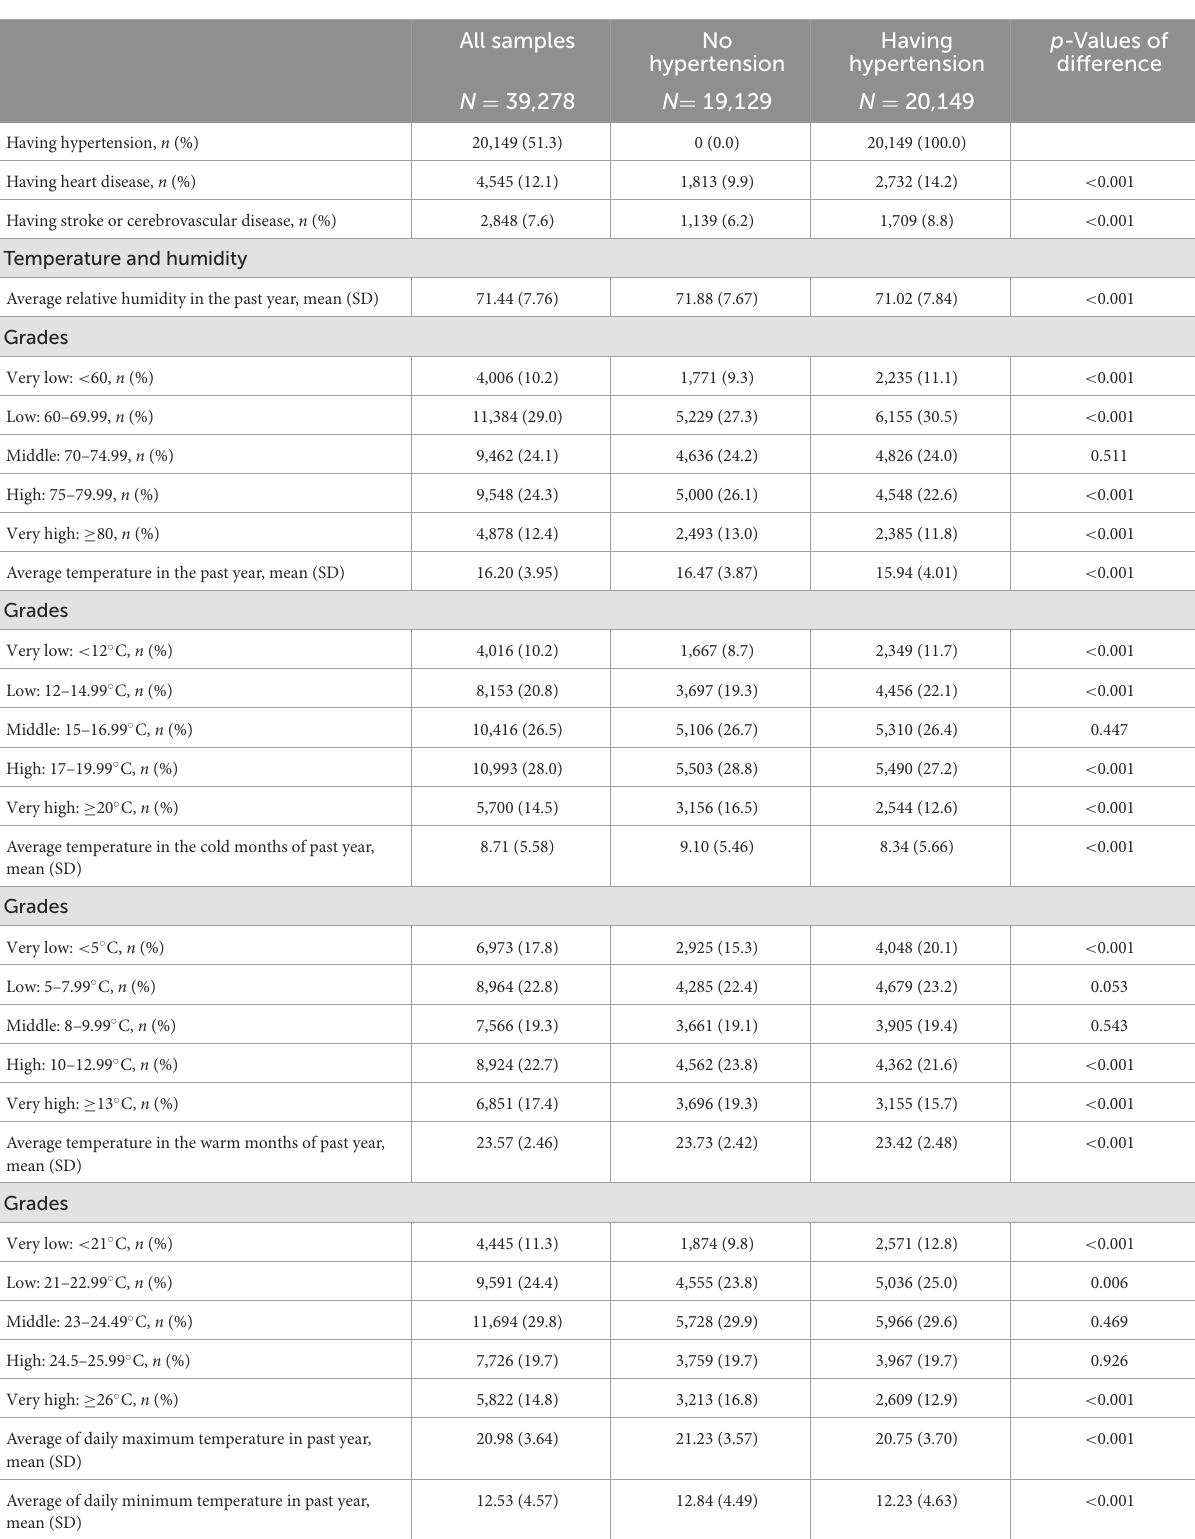
TABLE 1 Characteristics of the study samples, CLHLS 2002–2018.